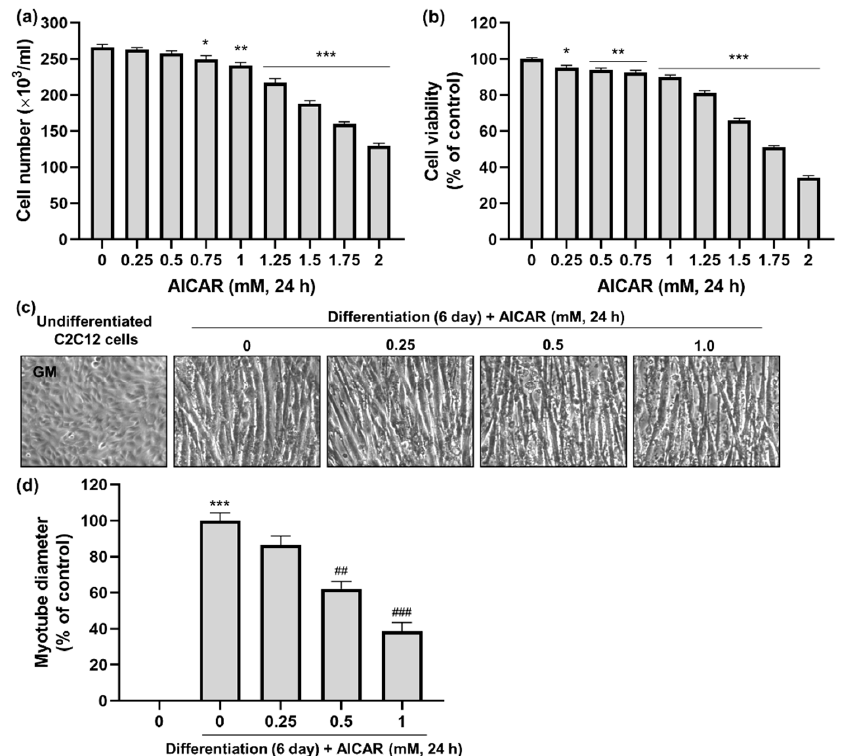
Figure 3. Effects of 5-aminoimidazole-4-carboxamide ribonucleoside (AICAR) on C2C12 myotube viability and differentiation. C2C12 cells were treated with indicated concentrations of AICAR and cultured for 24 h; cell counting ( a ) and MTT assay ( b ) were performed. Values and error bars indicate means ± SD of three separate experiments. Asterisks indicate significant differences between RE- and vehicle-treated cells before differentiation (ANOVA; *, p < 0.05; **, p < 0.01; ***, p < 0.001); ( c ) Phase-contrast micrographs of C2C12 cells before and after 6 d of differentiation when cultured with different concentrations of AICAR. GM: growth medium. 200 × magnification; ( d ) C2C12 cell diameter before and after 4 d of differentiation when cultured with different concentrations of AICAR. Values and error bars indicate means ± SD of three separate experiments. ***, significant difference between RE- and vehicle-treated cells before differentiation (ANOVA, p < 0.001); ##, significant difference between RE- and vehicle-treated cells after differentiation (ANOVA, p < 0.01); ###, significant difference between RE- and vehicle-treated cells after differentiation (ANOVA, p < 0.001).